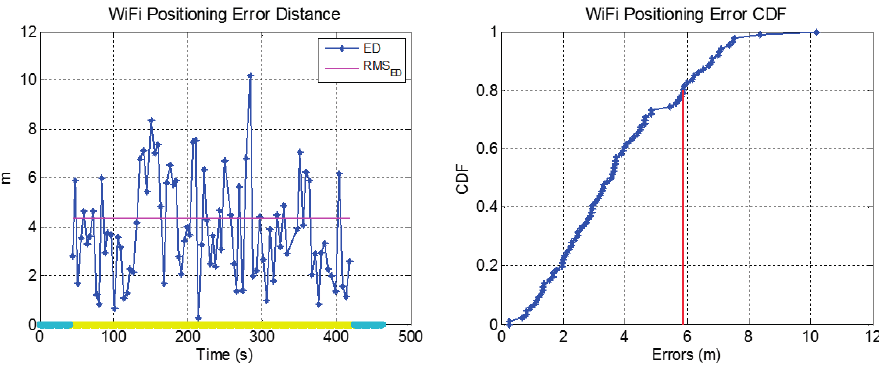
Figure 12. WiFi position errors at EEEL.